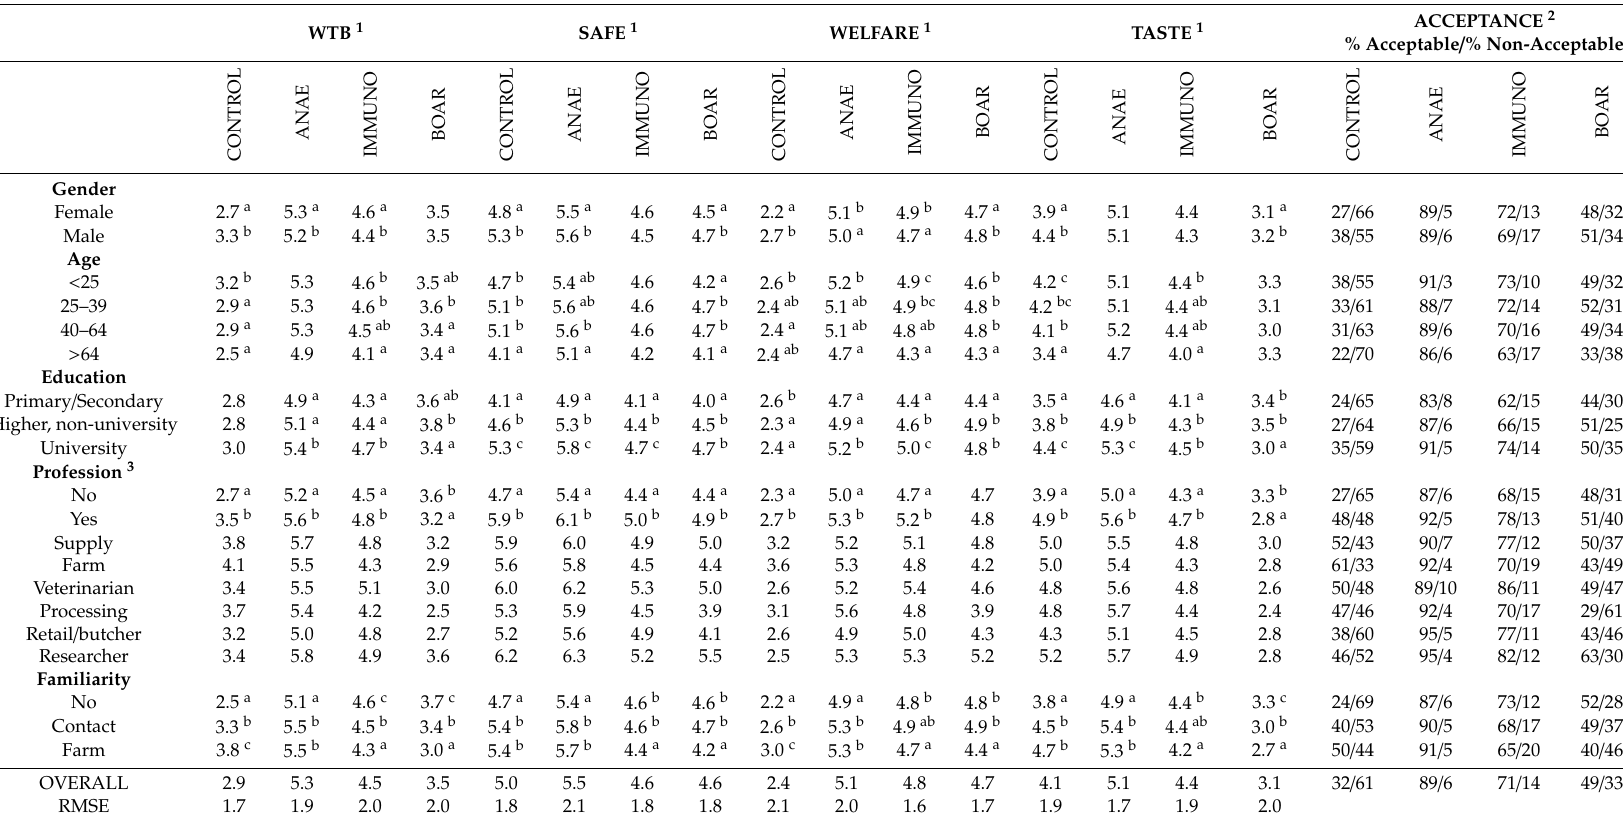
Table 3. E ff ect of the demographic variables on the agreement to the di ff erent statements and the acceptability of the di ff erent options (Castration without pain relief—CONTROL, castration with anaesthesia—ANAE, Immunocastration—IMMUNO, and no